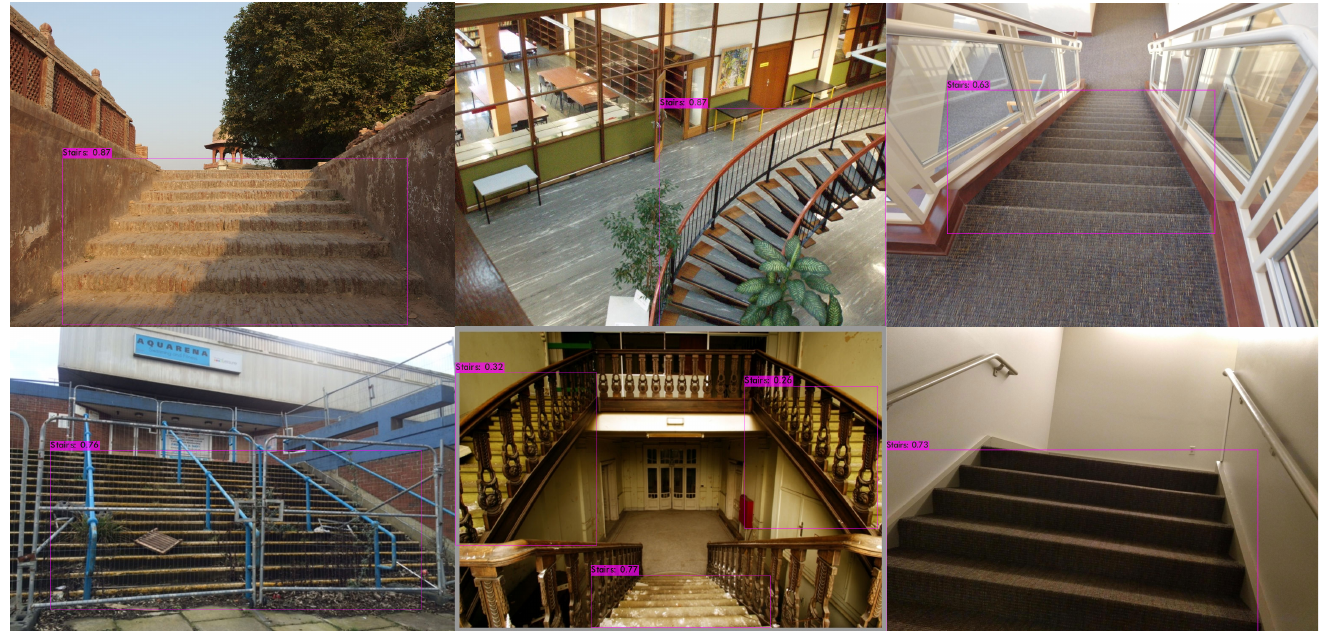
Figure 7. Results obtained using detector 9 in images taken from test